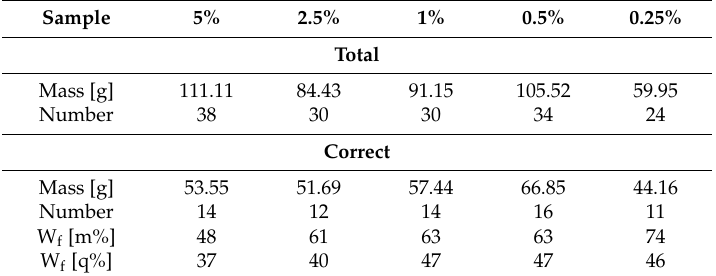
Table 1. Masses and the numbers of models examined in order to establish waste factor